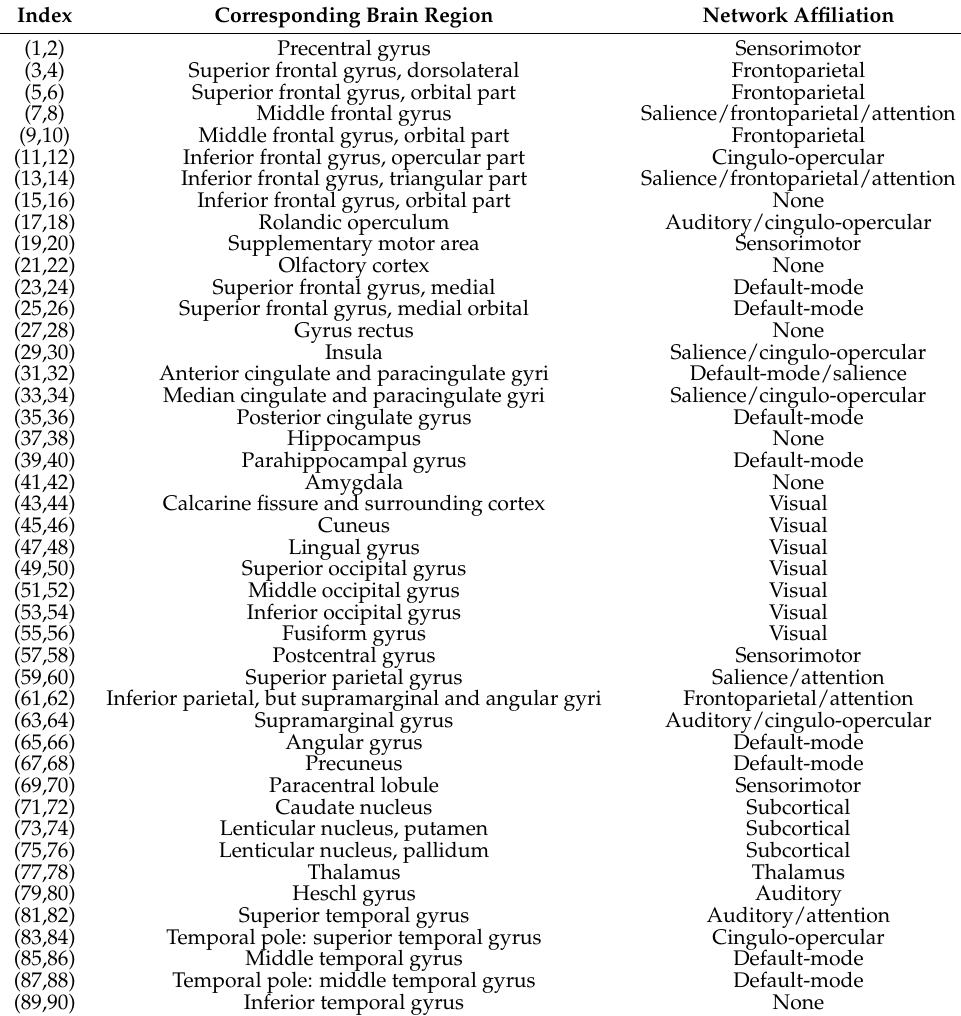
Table A1. List of the 90 regions of interest used in the present study and their network affiliations based on prior research. Odd and even numbers represent left and right hemispheres,